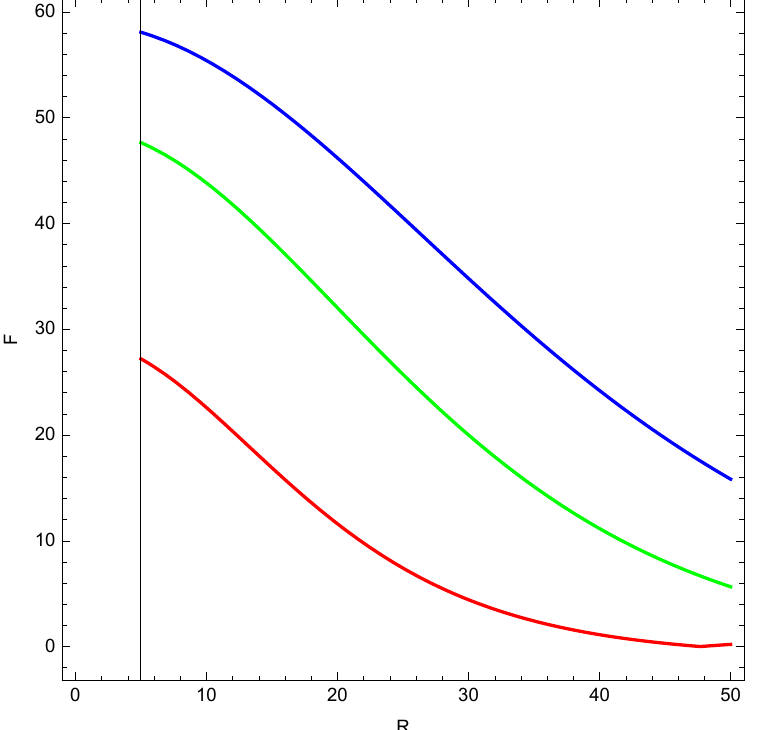
Figure 31. The evolution of F is obtained using Equations (33) and (46). The red, green, and blue lines correspond to small perturbations of R T and µ ,